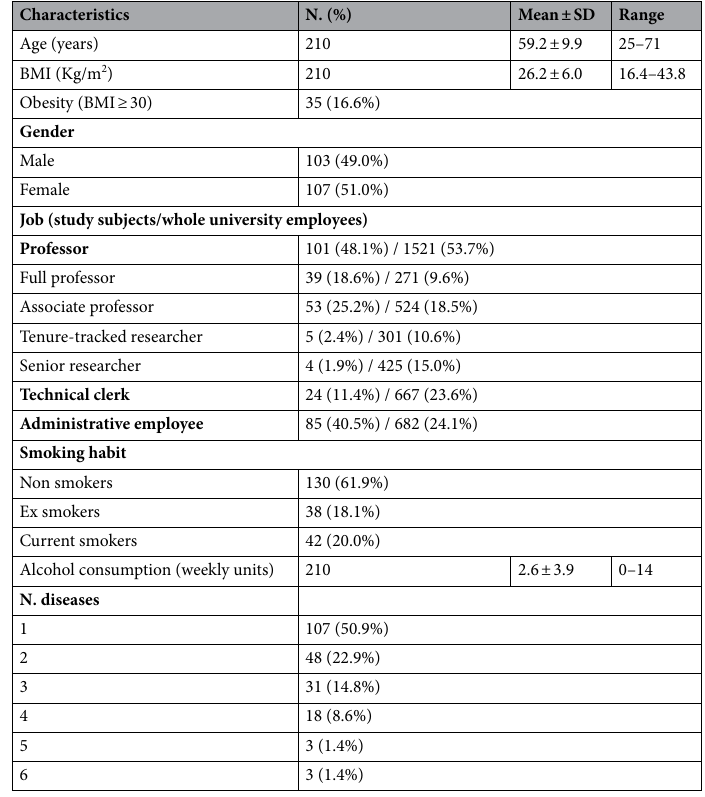
Table 1. General characteristics, job and number of diseases in the study subjects.